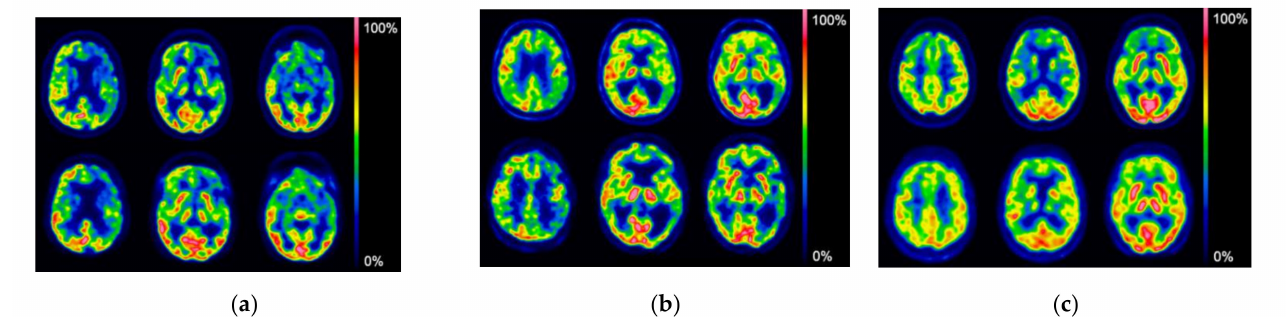
Figure 1. Three representative axial brain slices of [ 18 F]FDG PET images (upper row) and their corresponding FMF for each A β radiotracer (lower row) are shown using a rainbow color scale in the Xeleris processing system (GE Healthcare, Chicago, IL, USA). ( a ) [ 18 F]FBB FMF: 68-year-old male with mild dementia and non-fluent variant PPA (nfvPPA), suggests FTD. [ 18 F]FDG PET and [ 18 F]FBP FMF show severe left frontal involvement and left parietal and temporal involvement. The amyloid PET scan was negative. ( b ) [ 18 F]FMM FMF: 73-year-old male diagnosed with possible AD and amnestic long-term cognitive decline, and as an amnesic, with an MRI with atrophy, and a history of alcoholism. [ 18 F]FDG PET and [ 18 F]FMM FMF show severe left parietal and frontotemporal involvement. The amyloid PET scan was positive. ( c ) [ 18 F]FBP FMF: 69-year-old woman diagnosed with probable AD due to hippocampal amnestic deterioration. Both the [ 18 F]FDG PET and [ 18 F]FBB FMF images show slight bilateral parietal involvement which is greater on the right side and slight right frontal involvement. The amyloid PET scan was positive. Table 2. Regional SUVRs of FMFs and [ 18 F]FDG PET.